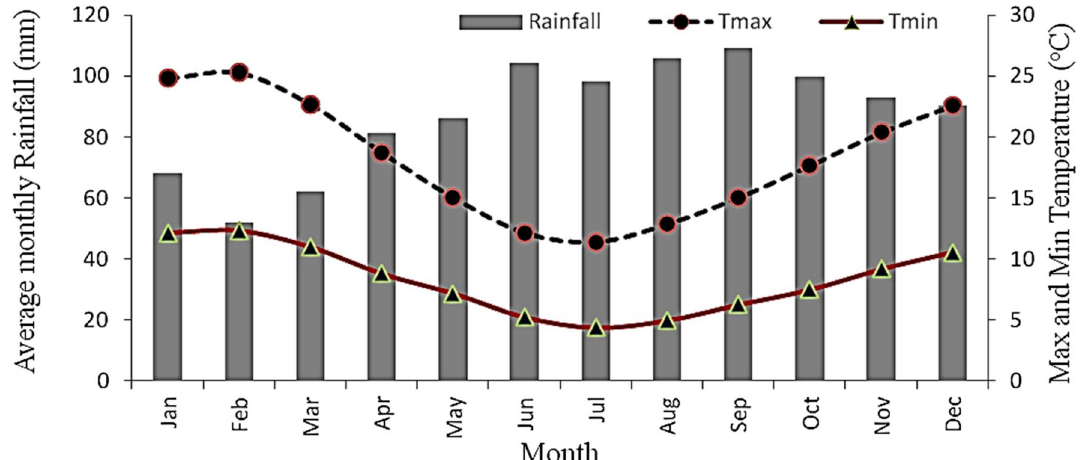
Fig. 3 Relation between monthly average temperature and precipitation (min and max) in the MYS